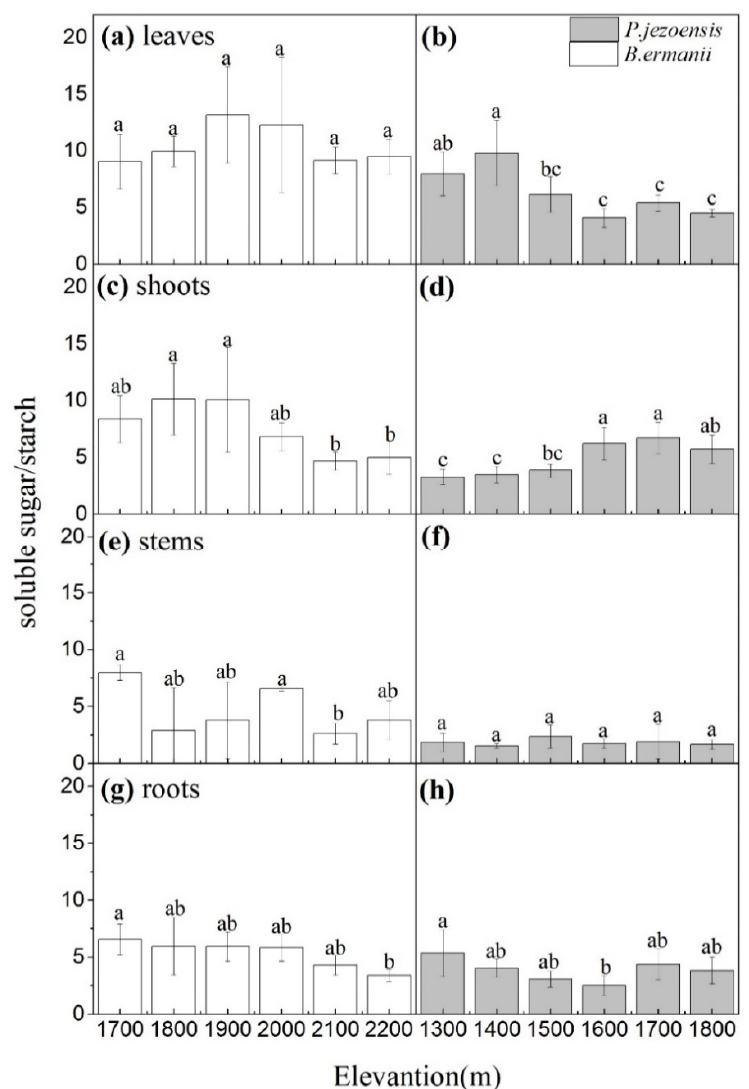
Figure 6. The changes in the soluble sugars/starch ratio (mean ± SD) of B. ermanii (a) leaves, (c) shoots, (e) stems and (g) roots as well as P. jezoensis (b) leaves, (d) shoots, (f) stems and (h) roots along with elevational gradients in Changbai Mountain ( n = 5 for each elevational site and tissue type). Different letters indicate significant differences ( p < 0.05) among elevations as determined by Tukey’s HSD test single-factor ANOVAs.